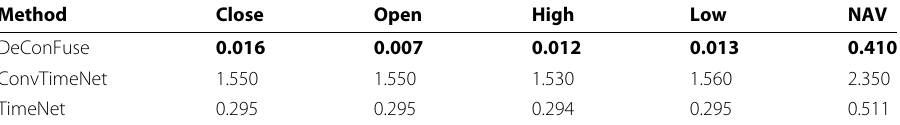
Table 3 Summary of forecasting